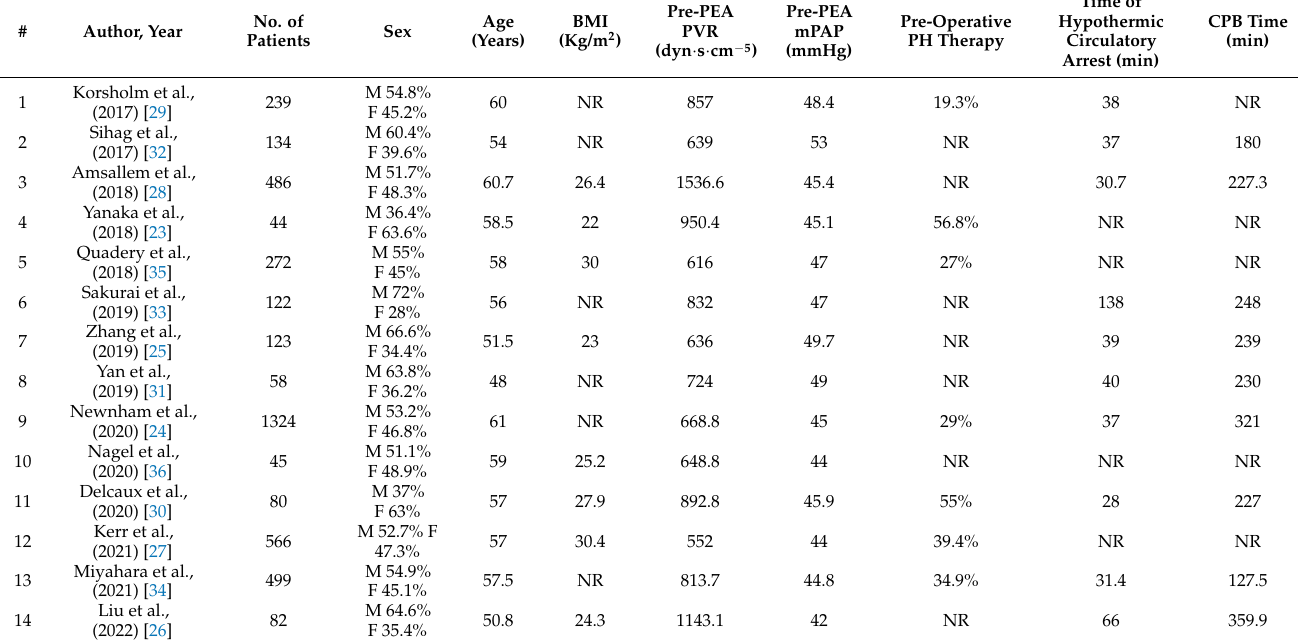
Table 2. Baseline, pre-operative, and intra-operative features of patients treated with